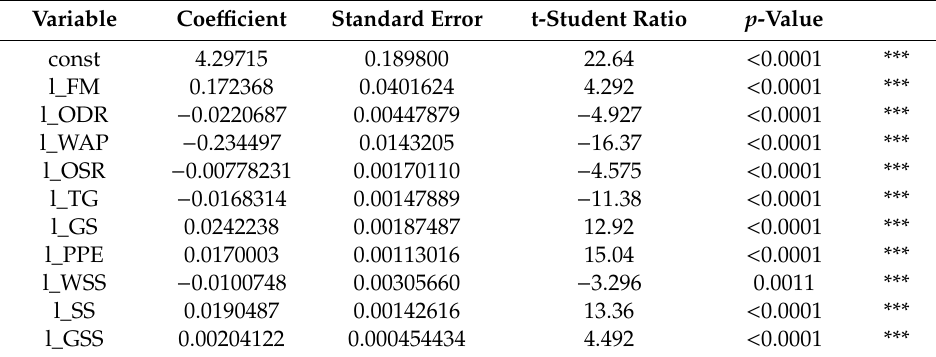
Table 6. The least squares (OLS) Model 1 (dependent variable LE(m) = 0).